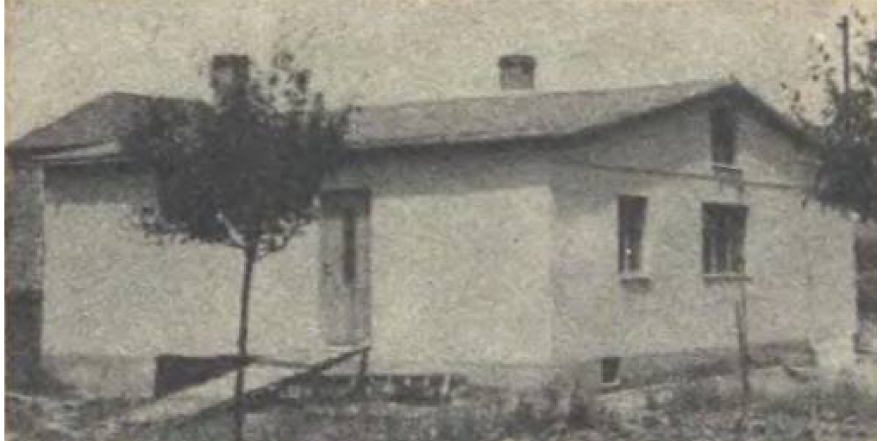
Figure 3. A family house made of SOLOMIT boards, a product of the company OSP Olomouc, Czechoslovakia (1959)